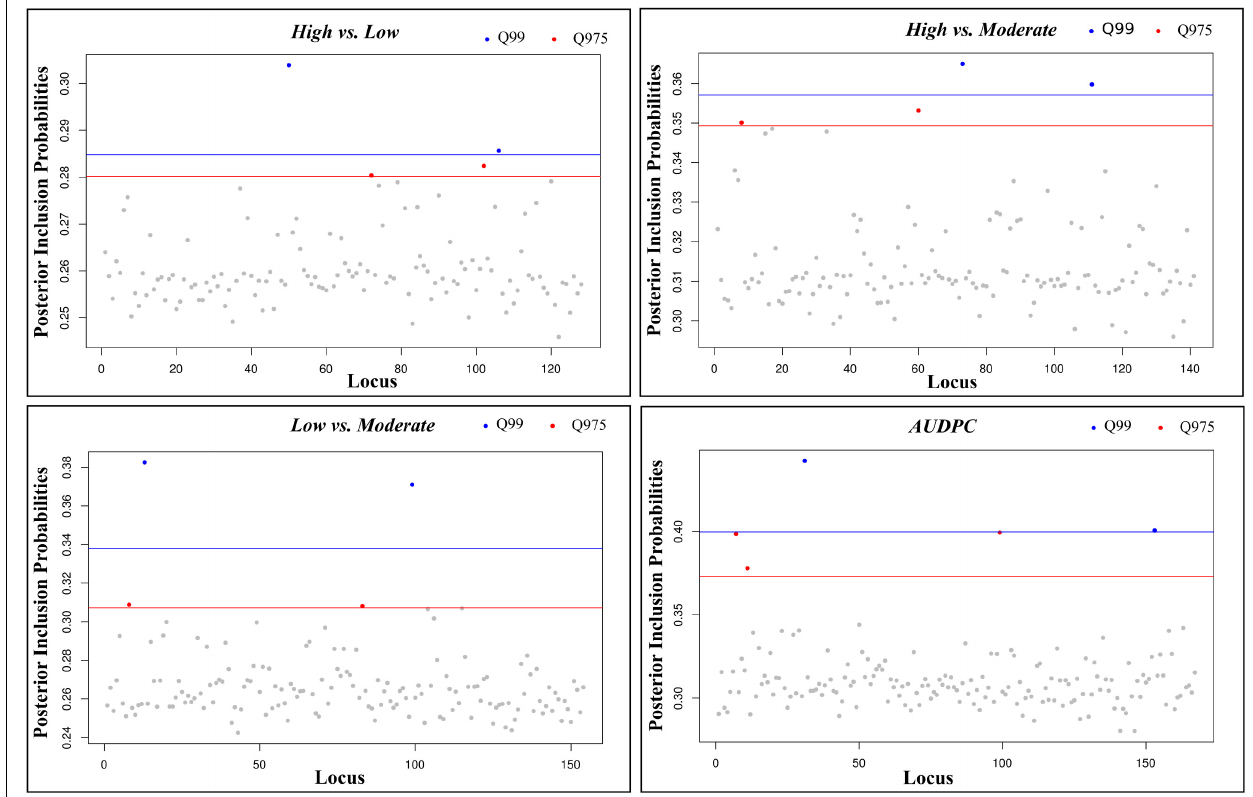
FIGURE 6 | Posterior inclusion probabilities (PIPs) for each SNP in each pairwise comparison in multi-SNP association test. The horizontal blue lines correspond to the PIP 99% empirical quantile threshold and red lines to the 97.5% empirical quantile. Blue dots: SNPs with a PIP > 99% empirical quantile, Red dots: SNPs with a PIP > 97.5% empirical quantile, Light gray dots: SNPs with a PIP < 97.5% empirical